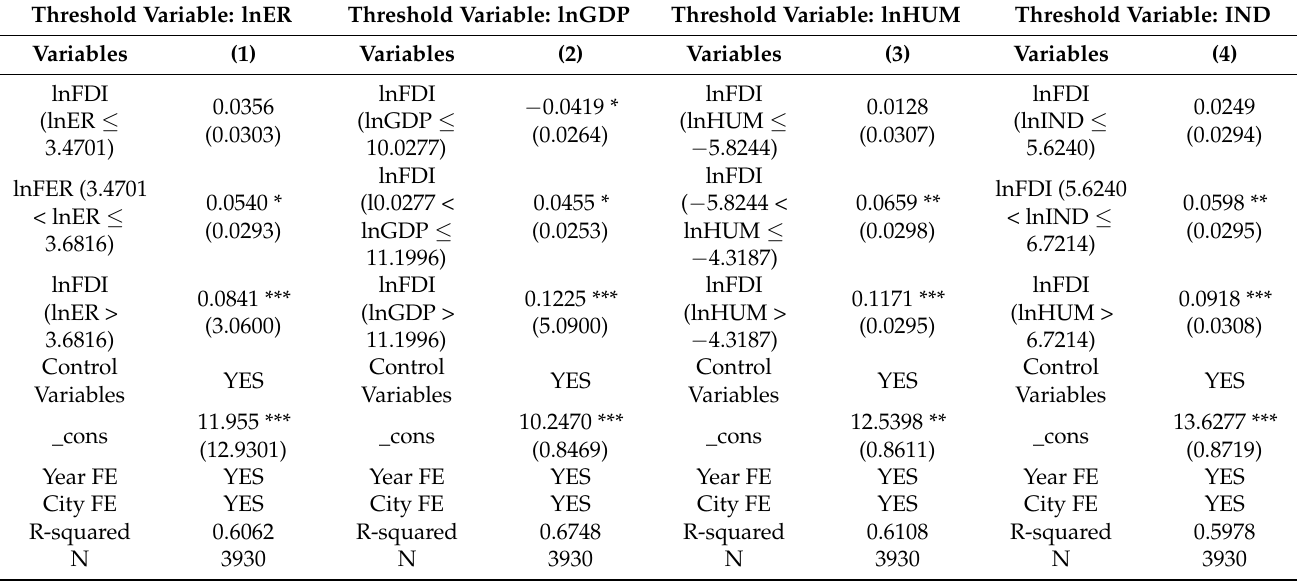
Table 5. Robustness Test excluding the influence of singular values.